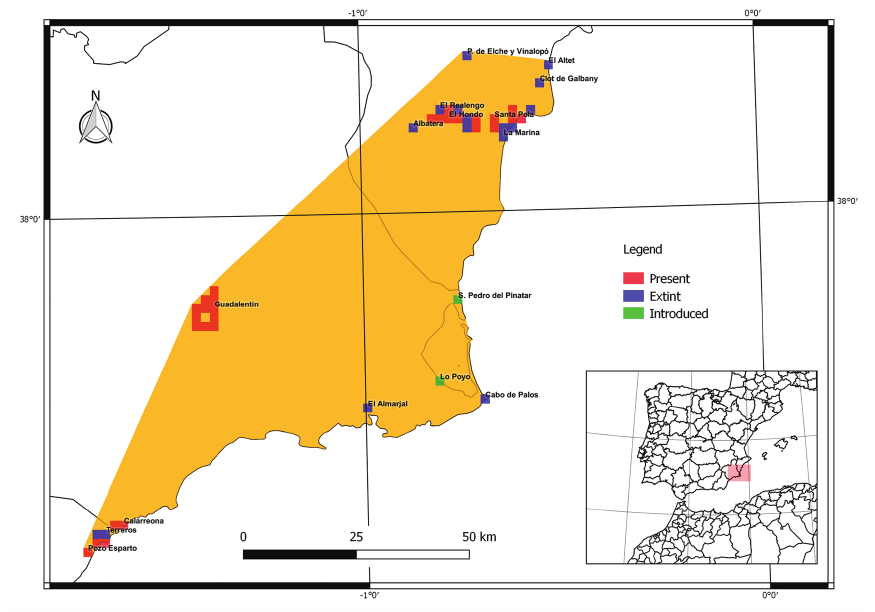
Figure 6. Extent of Occurrence (orange) and Area of Occupancy (2 × 2 km cell grid) of Halocnemum cruciatum in